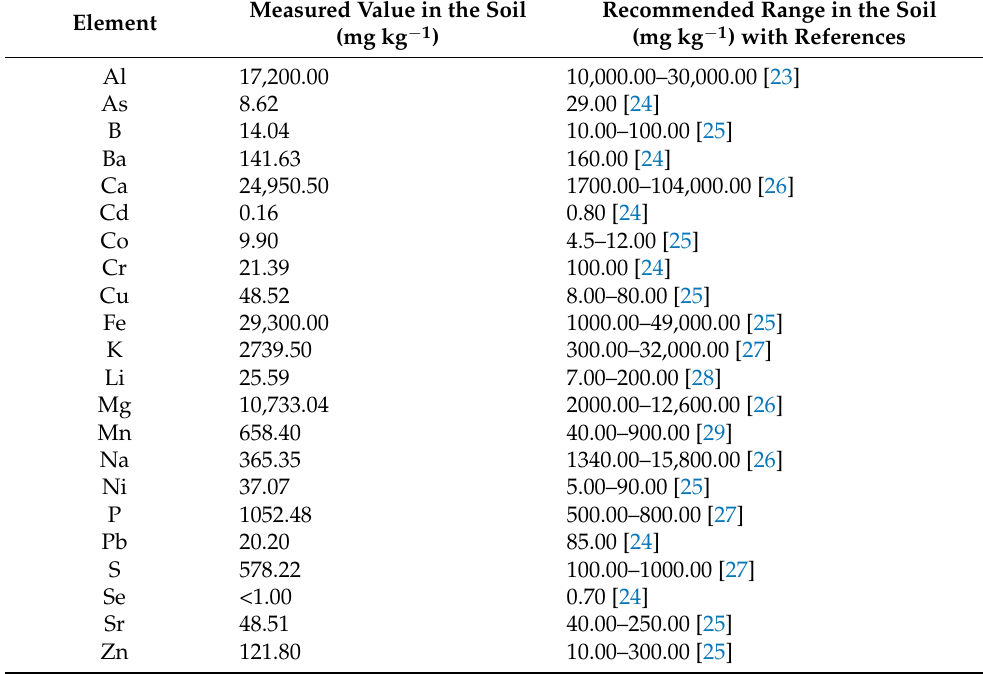
Table 1. The contents of macro and microelements in the soil in the experimental